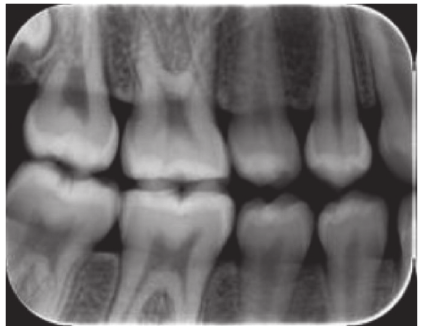
Figure 3: Bitewing radiograph.